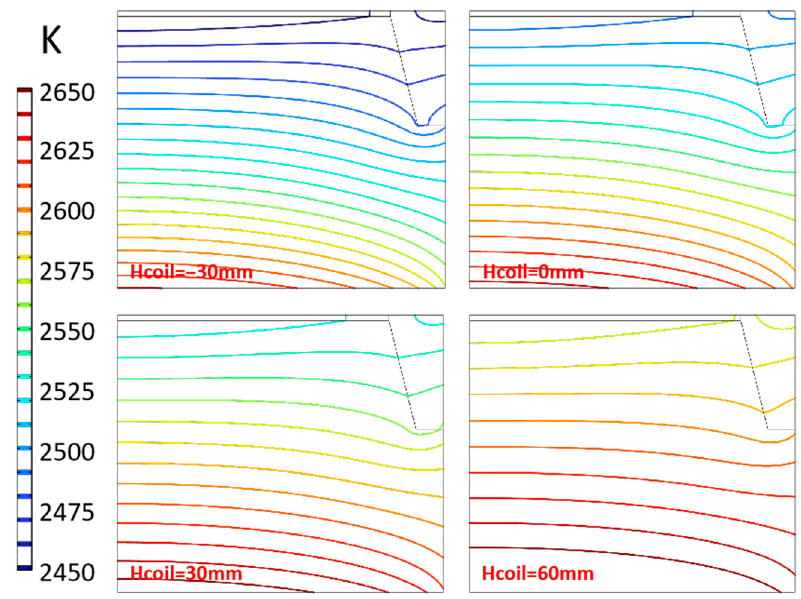
Figure 13. Isotherms distribution in chamber.